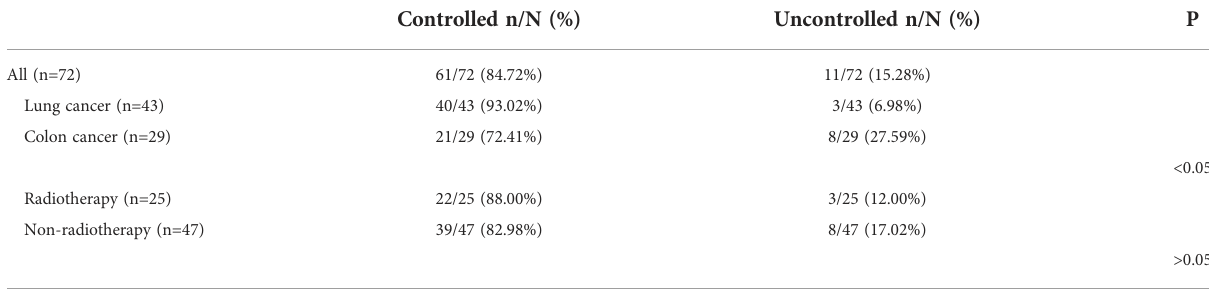
TABLE 3 Edema control rate of each group after